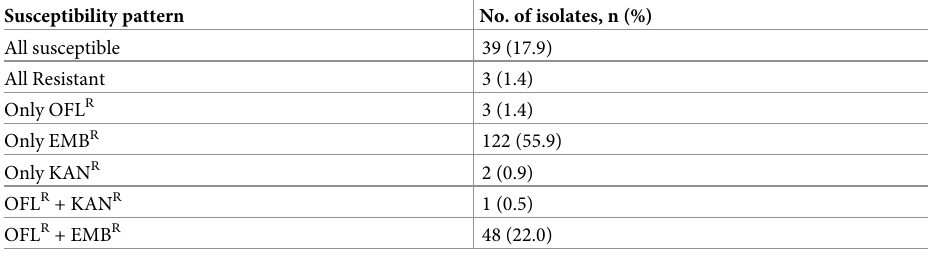
Table 2. Phenotypic drug susceptibility patterns of MDR-TB isolates to OFL, KAN and EMB